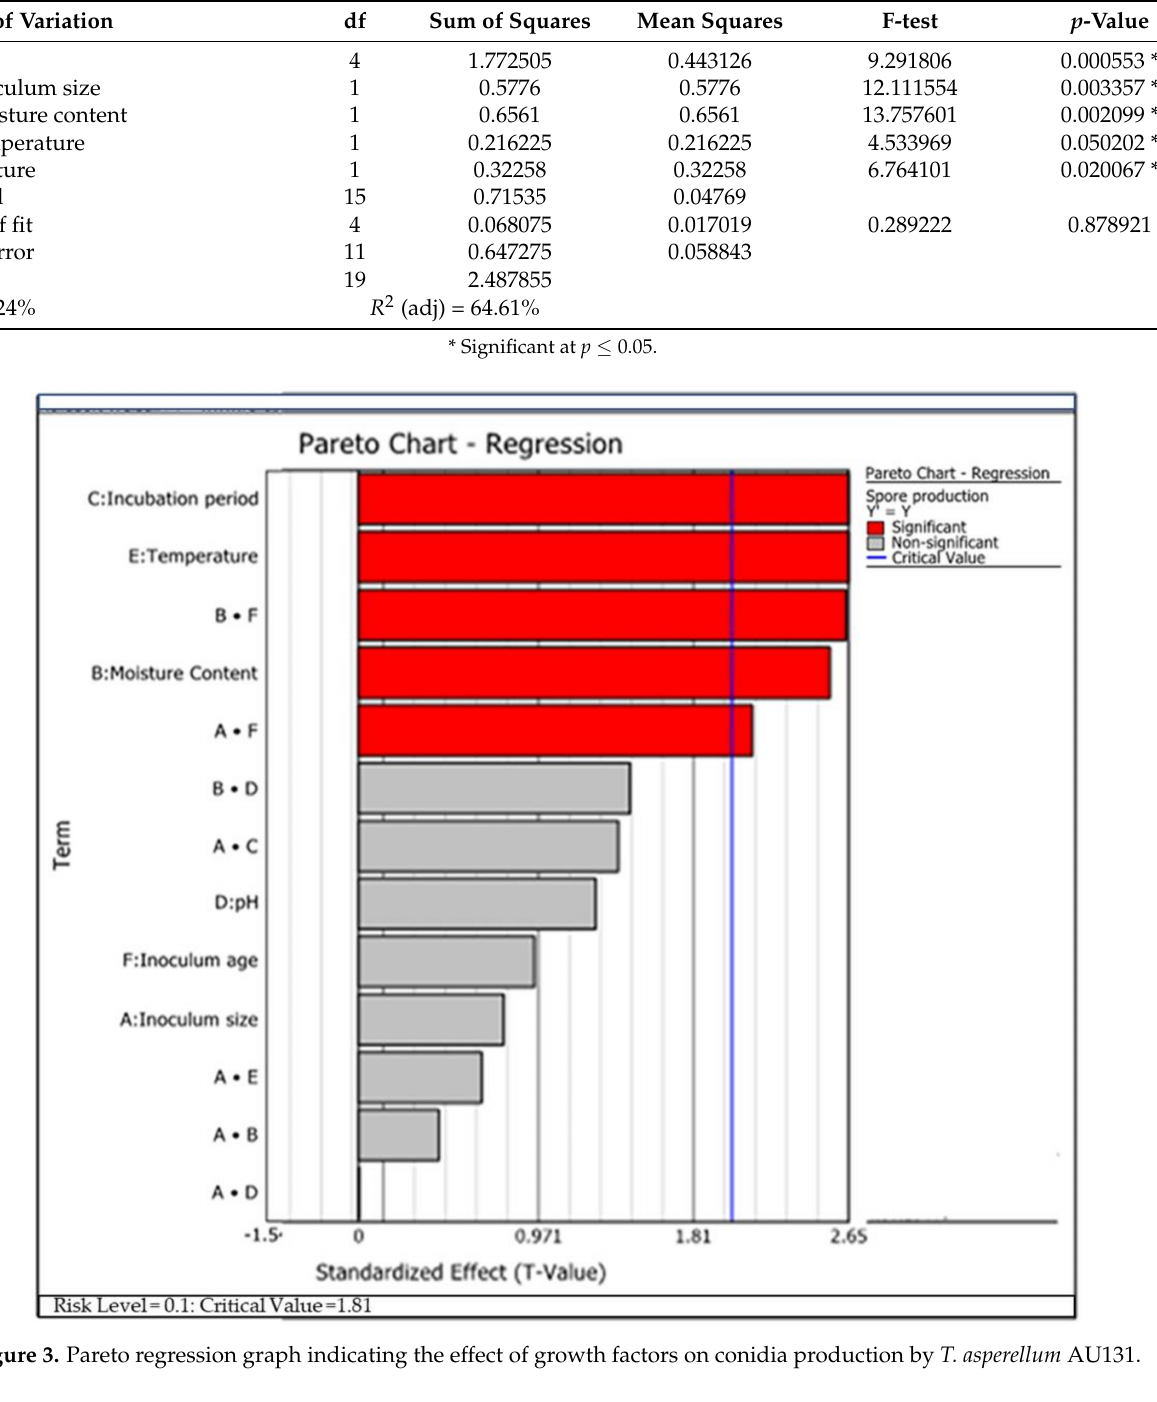
Table 8. ANOVA statistical data of fractional factorial design for screening critical growth factors of T. longibrachiatum AU158.